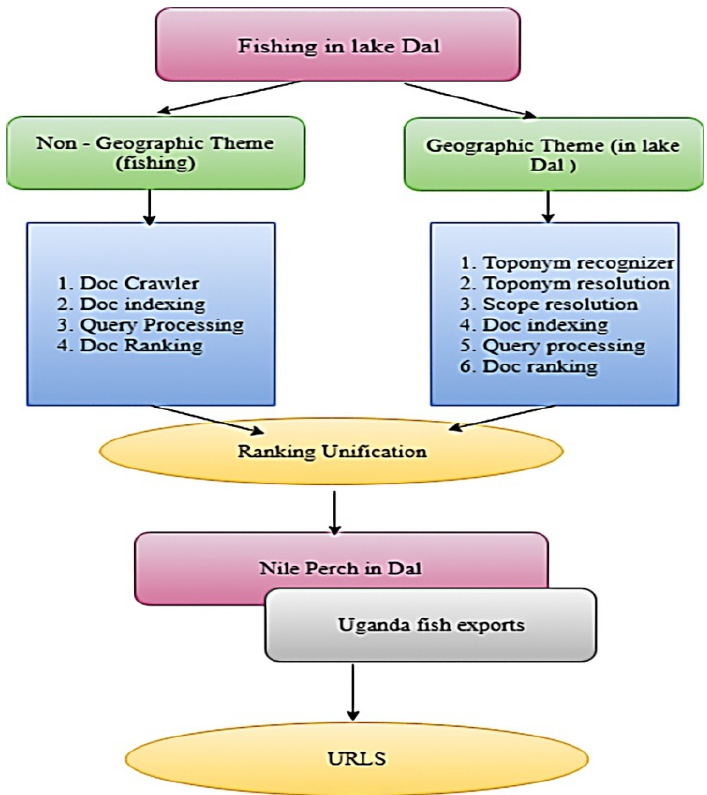
Figure 1. Common GIR processing Process (Andogah Geofrrey,